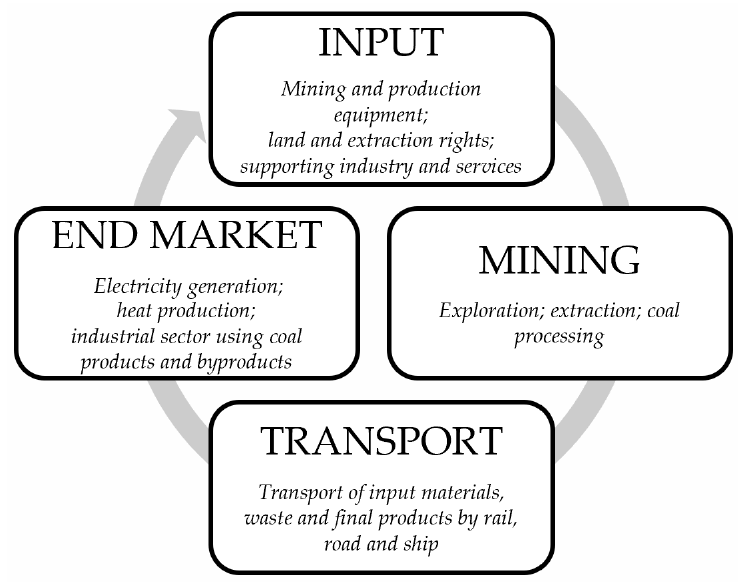
Figure 1. Representative diagram of the coal value chain.